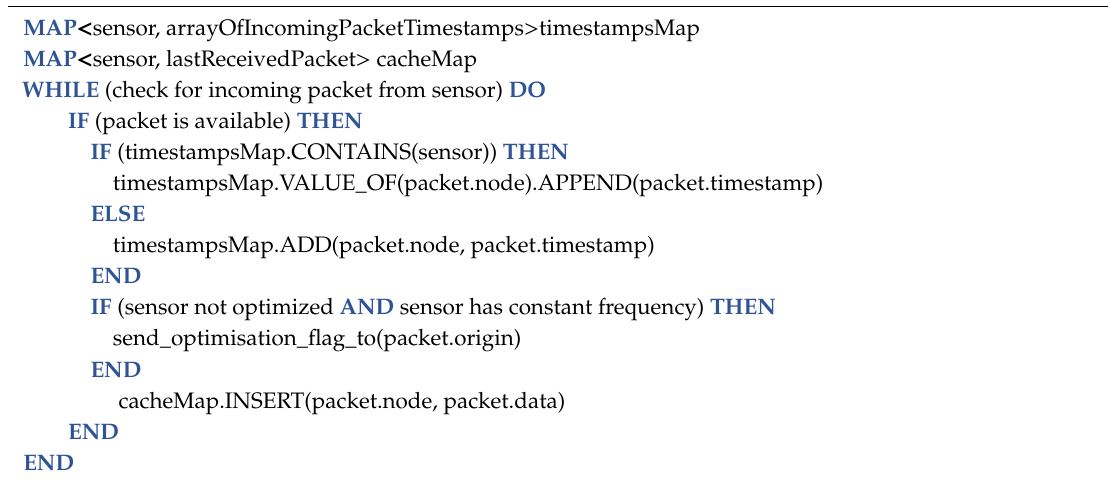
Procedure 2 . Control component algorithm for learning the sensor nodes behavior. MAP < sensor, arrayOfIncomingPacketTimestamps >